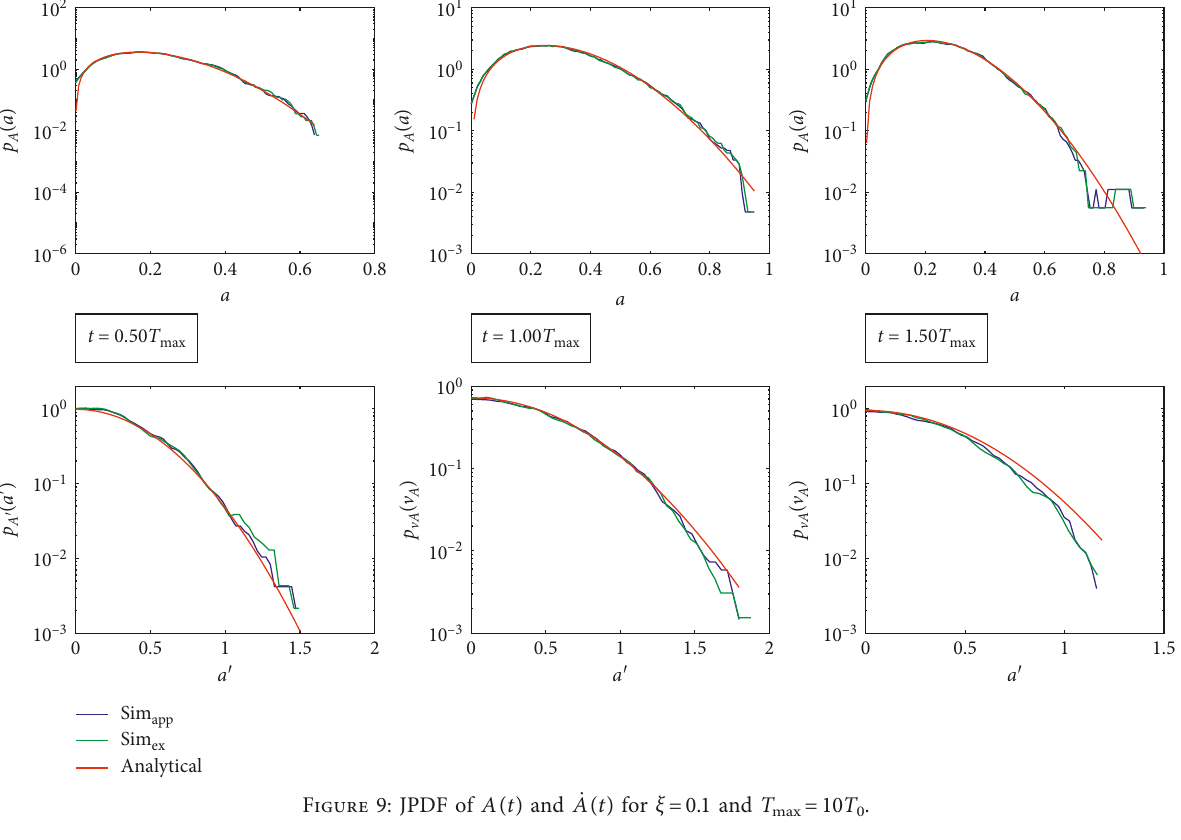
0.1 and T max (cid:31)